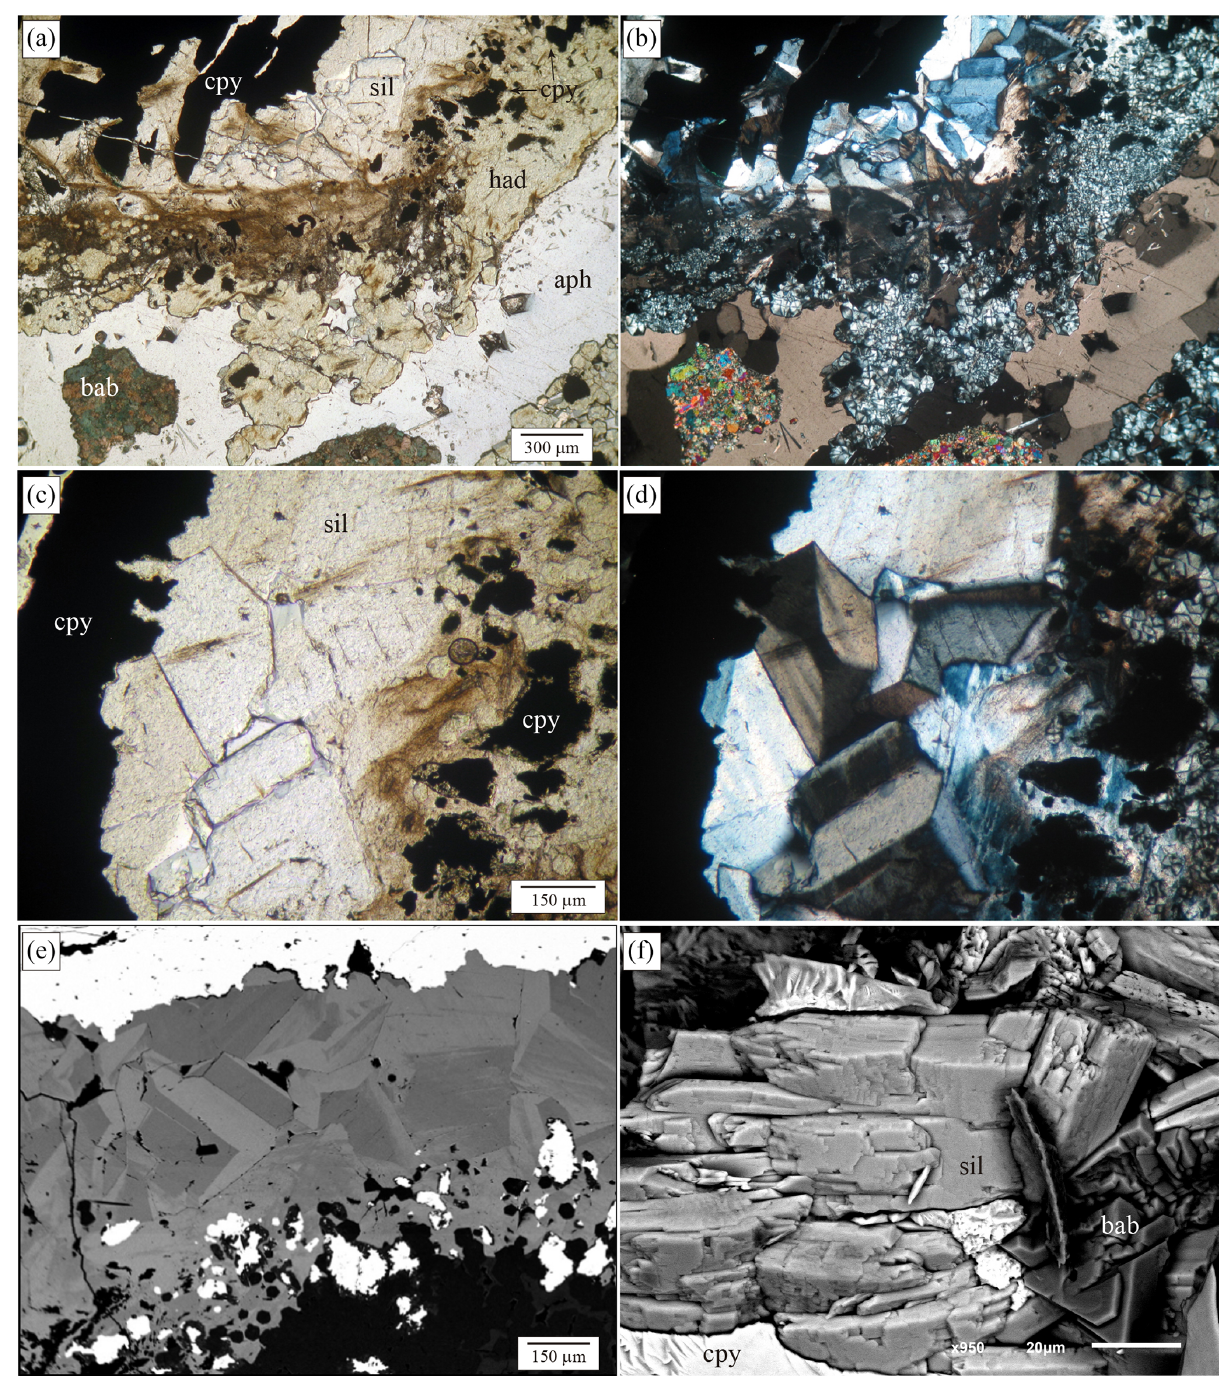
Figure 2. (a) Microphotography showing the silesiaite (sil) and hydroandradite (had) crystal aggregates surrounding and replacing chal- copyrite (cpy). Apophyllite-(KOH) and babingtonite (bab) appear to be filling the cavity under plain polarized light. (b) The same image under polarized and analysed light. The mineral has anomalous ink blue and leather brown interference colours. (c) Detail of the silesiaite aggregates in which a weak pleochroism from uncoloured to yellowish is observed. (d) The same image under polarized and analysed light. One of the sections has an hourglass zoning and something resembling polysynthetic twins with thin plates. (e) Backscattered electron im- age that shows the compositional zoning mimicking the optical zoning. Light grey areas are rich in Sn, and dark grey areas are rich in Fe. (f) Secondary electron image of a tiny fragment of the sample. It shows an aggregate of some silesiaite crystals with a tabular habit and an imperfect cleavage of the